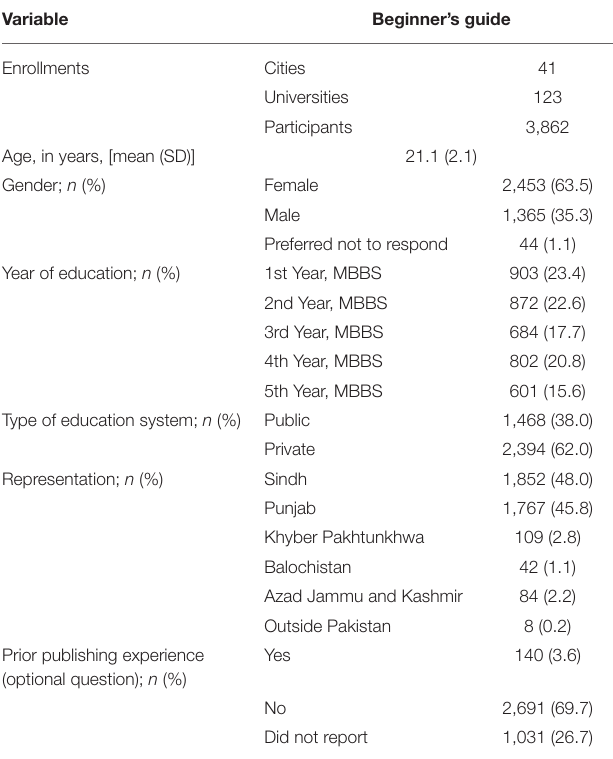
TABLE 2 | Enrollments, demographics and participant characteristics ( n =